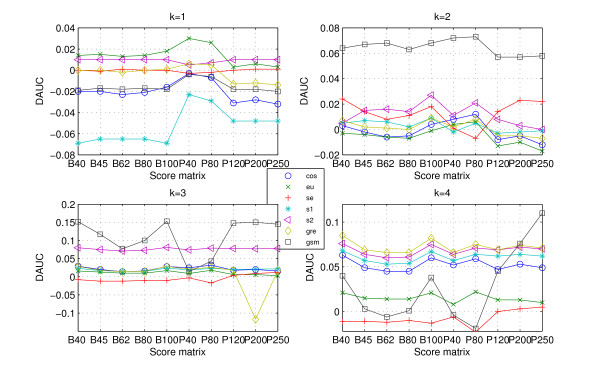
DAUC values for data RS. The DAUC values of seven statistical measures for data RS. All statistical measures based on k-word frequencies of protein 'sequence space' run with k from 1 to 4, where protein 'sequence space' is constructed according to ten score matrices. One graph presents each word length (from 1 to 4).